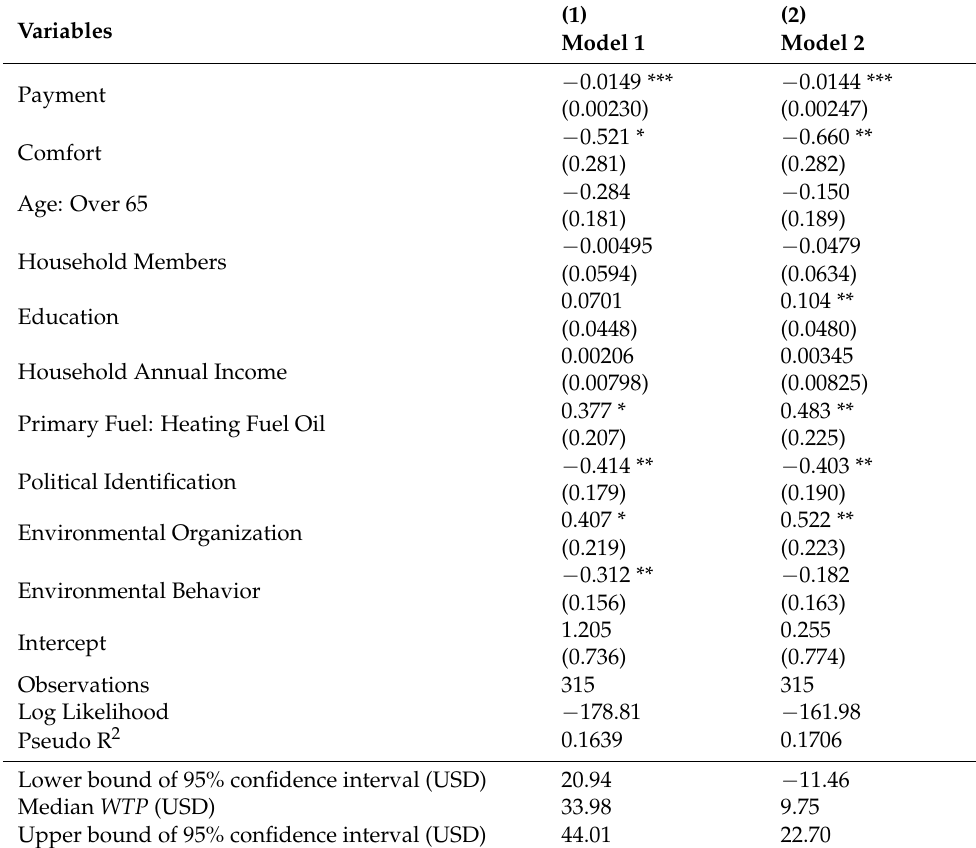
Table 5. Maximum Likelihood Estimation